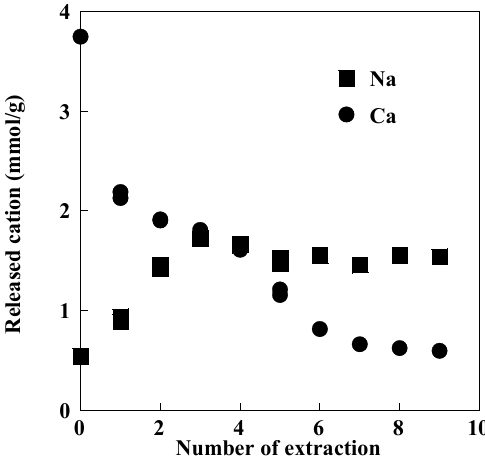
Figure 5. Amounts of Ca and Na released from products, synthesized from leached ashes, into ammonium acetate solution, as a function of the number of leaching treatments for the ash.